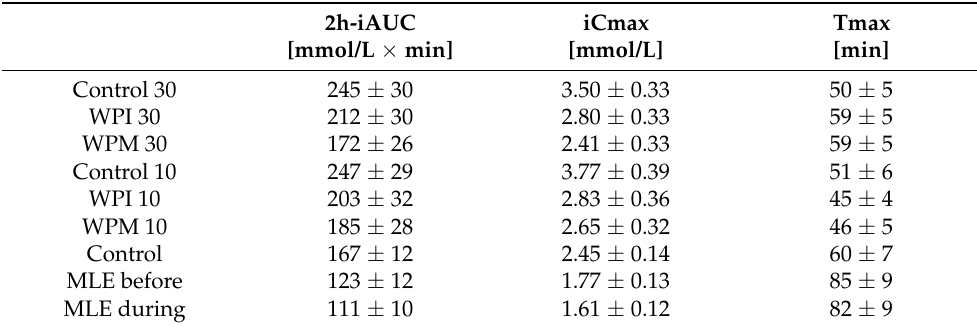
Table 3. Descriptive statistics (mean ± SE) for the nine tested conditions with n = 14 for the protein premeal study and n = 30 for the MLE study.